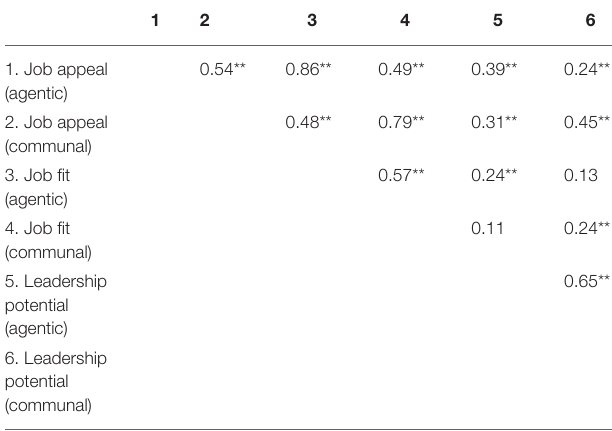
TABLE 6 | Study 2: correlation matrix for job appeal (agentic and communal), job fit (agentic and communal), and self-rated leadership potential (agentic and